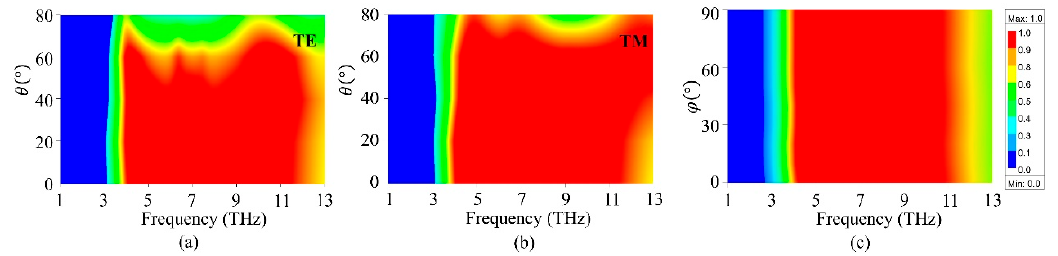
Figure 5. ( a , b ) Absorption maps as a function of incident angles θ for TE and TM polarization, respectively. ( c ) The absorption map for various polarization angles ϕ under normal incidence.